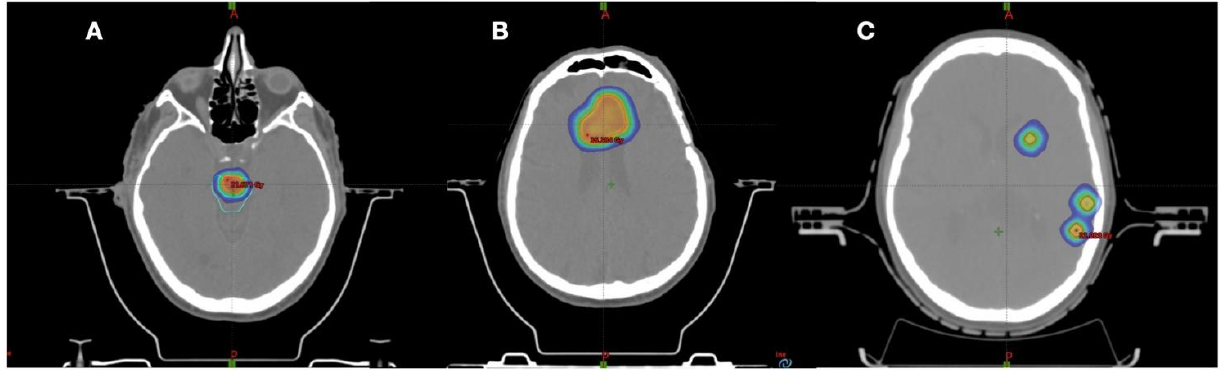
Figure 1. Examples of re-irradiation treatment plans. ( A ) Glioblastoma recurrence in brain stem treated with SFRT 18 Gy in three fractions, ( B ) glioblastoma recurrence treated with SFRT 30 Gy in five fractions, ( C ) multiple lesions for young patients with oligodendrogliomas treated with SFRT with HyperArc approach 18 Gy in three fractions. Table 2. Treatment characteristics for all population.